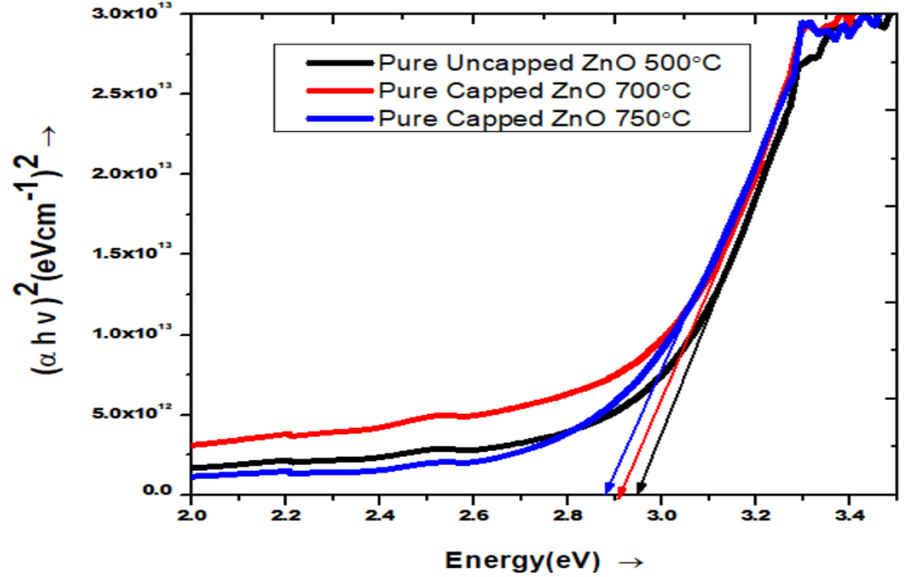
Figure 2. Absorbance spectra and Energy band gaps of pure ZnO with different temperatures.